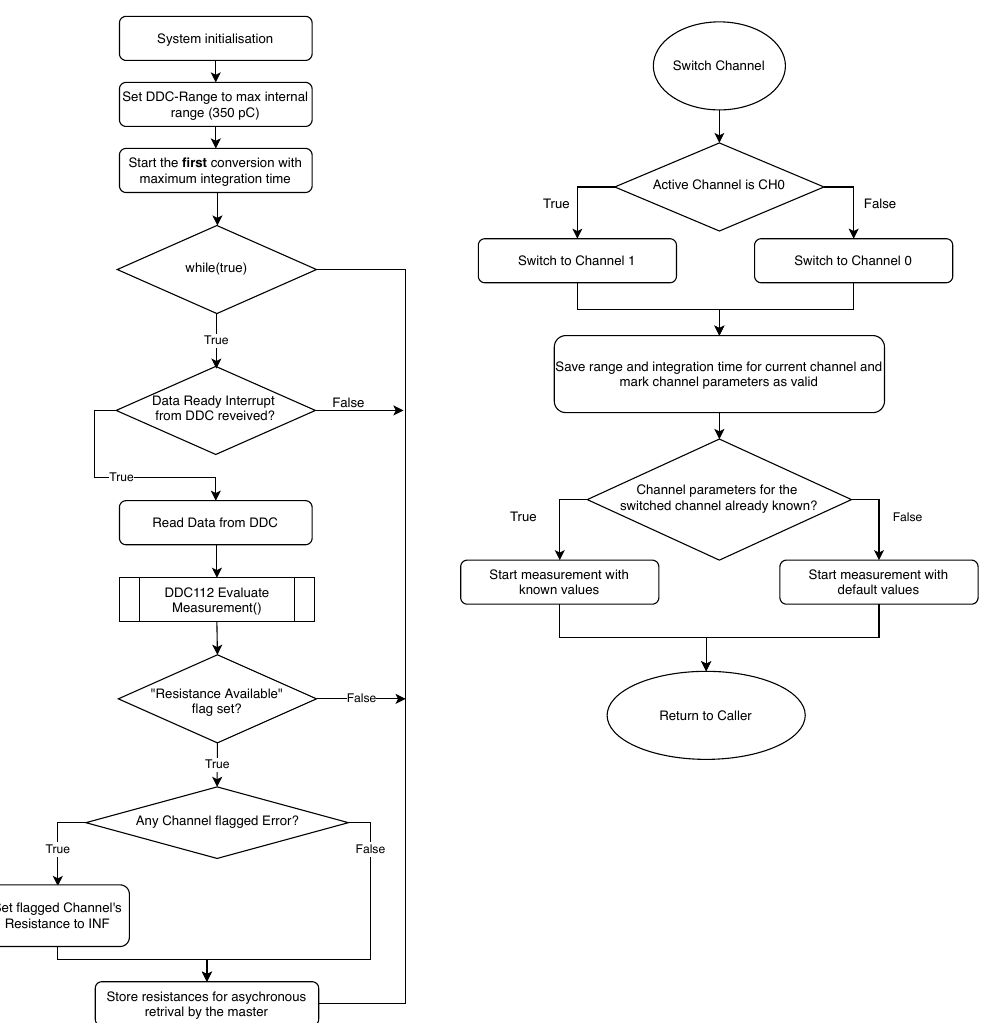
Figure 5. Simplified flow chart for the measurement algorithm helper